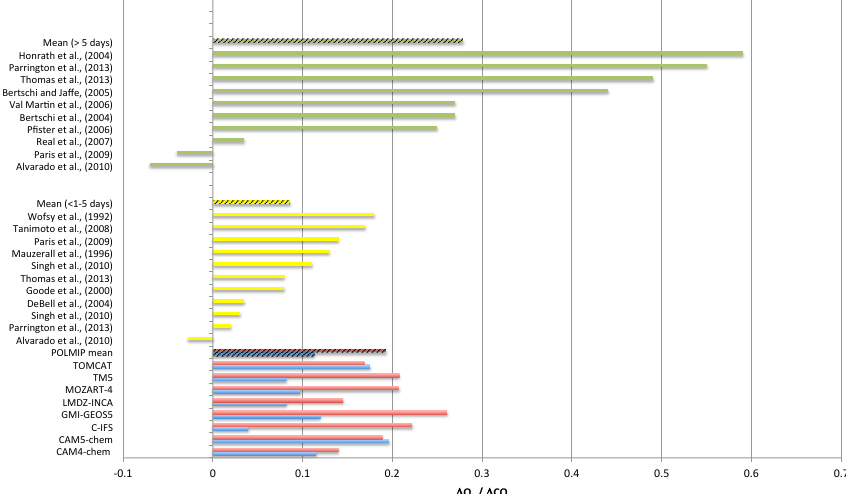
Figure 6. (cid:49) O 3 /(cid:49) CO ratios in boreal biomass burning pollution from previous studies and from the POLMIP model simulations analysed in this study. Green: values from plumes of age > 5 days; yellow: values from plumes of age < 1–5 days. POLMIP model values are classified by age since emission (red: aged; blue: young), based on the ln ( [ C 3 H 8 ] / [ C 2 H 6 ] ) concentration ratio (see text for details). Hatched bars indicate average values for each category. Literature values for previous studies are based on an updated version of the review of Jaffe and Wigder